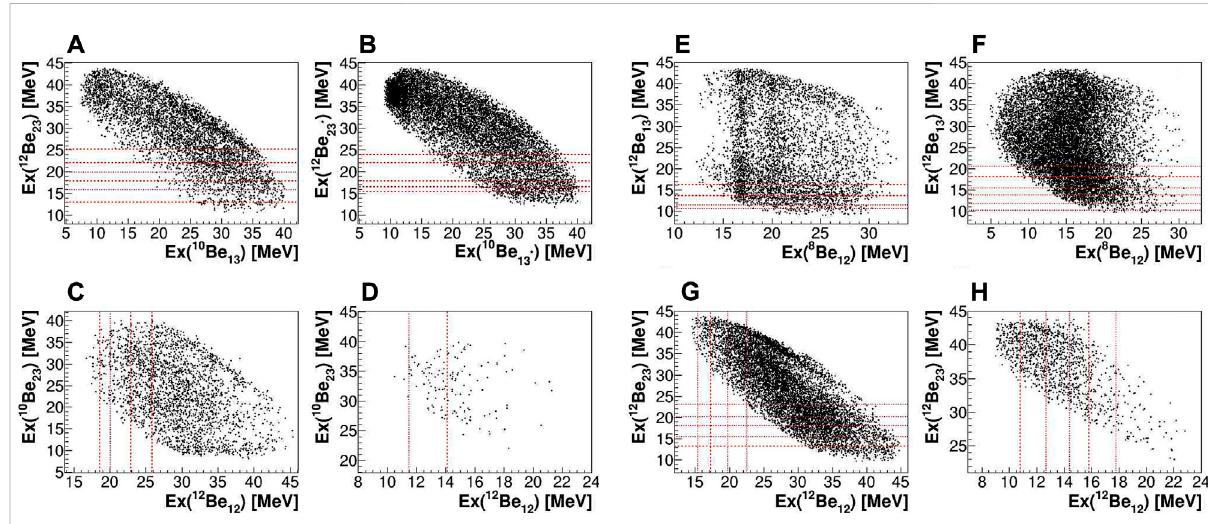
FIGURE 4 Typical correlation plots for the identi fi cation of excited states: 2D plots of excitation energy spectra reconstructed for composite systems madeofvariouspairsofthethree fi nalreactionproducts.PlotsA,B,C,andDarereconstructed foreventsassociatedwiththe 6 He+ 6 Hedecay,plots E,F,G,andHforthe 4 He+ 8 Hedecayofthe 12 Beexcitedstates. Spectraarereconstructed for the 4 He+ 6 HedT=3coincidencesforundetected 6 He inthegroundstate (A) andthe fi rstexcitedstateat1.8 MeV (B) ; 6 He+ 6 HecoincidencesfordT=3 (C) anddT=1 (D) ; 4 He+ 4 Hecoincidencesfor dT = 3 (E) and dT = 2 (F) ; 4 He + 8 He coincidences for dT = 3 (G) and dT = 1 (H) . The candidates for the 12 Be states are marked with the